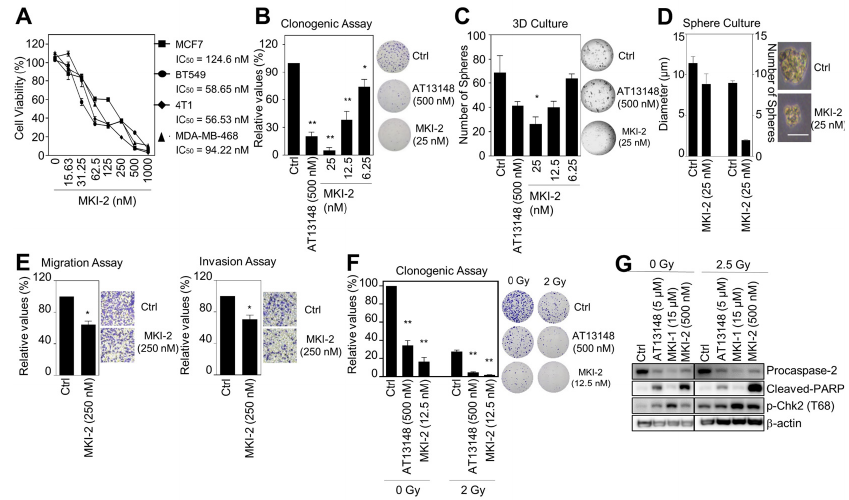
Figure 4. MKI-2 inhibits the oncogenic properties and enhances the radiosensitivity of breast cancer cells ( A ) MCF7, BT549, 4T1, and MDA-MB-468 cells were treated with serial dilutions of MKI-2 from 1000 nM for 72 h. The cell viabilities were measured using the WST-8 assay. ( B – E ) MCF7 cells were treated with DMSO (Ctrl), 500 nM AT13148, and the indicated concentrations of MKI-2. ( B ) Colony formation was determined using the colony formation assay. Representative images (right panel) of colony formation of MCF7 cells. ( C ) Spheroid formation was determined using the 3D culture assay. ( D ) Mammosphere formation was determined using the sphere formation assay. Scale bars = 100 µ m. Representative images (right panel) of the colony, spheroid, and tumorsphere formation of MCF7 cells ( B – D ). ( E ) BT549 cells were used for migration and invasion assays. Representative images (right panel) of migration and invasion of BT549 cells. ( F , G ) MCF7 cells were treated with DMSO (Ctrl), 0.5 µ M AT13148, and 12.5 nM MKI-2 with or without 2.5 Gy radiation for 14 days ( F ) or 24 h ( G ). Colony formation was determined by using the colony formation assay. Representative images (right panel) of the colony formation of MCF7 cells treated with indicated conditions. Cell lysates were analyzed by immunoblotting with the indicated antibodies ( G ). The data represent typical results and are presented as the mean ± standard deviation of three independent experiments. * p < 0.05, ** p <